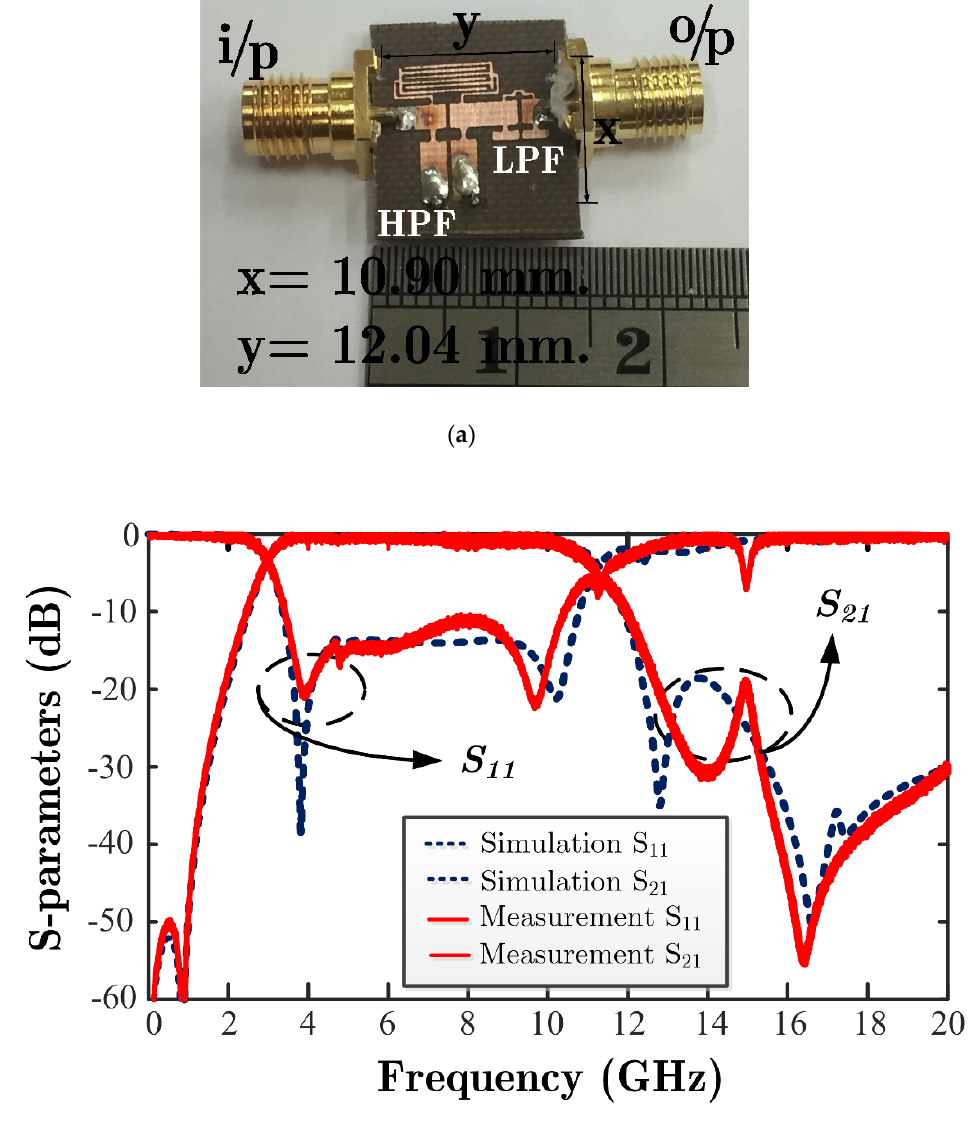
Figure 9. The prototype of the UWB-BPF: ( a ) A photograph of the proposed UWB-BPF and ( b ) the simulated and measured results of the proposed UWB-BPF.